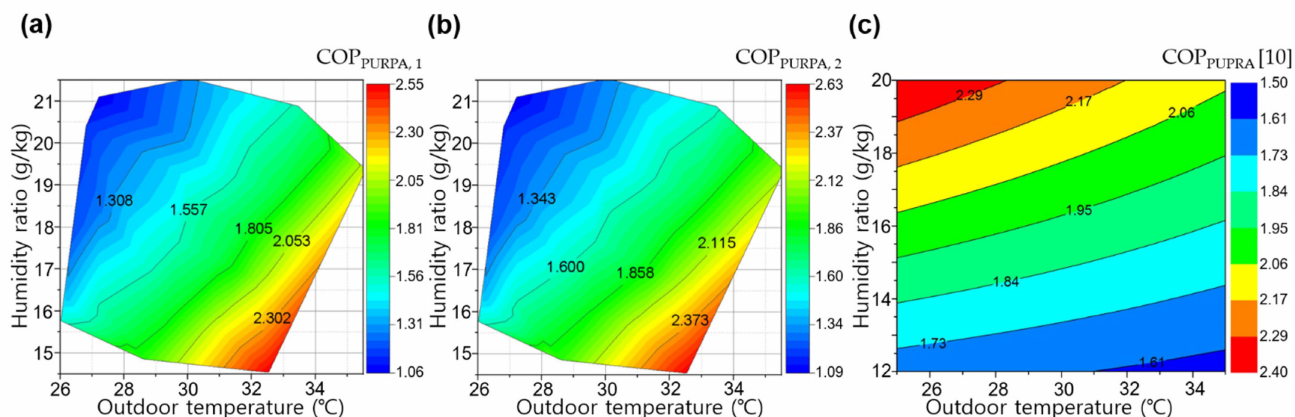
Figure 12. COP with thermoelectric value (COP PURPA ) from the Public Utility Regulatory Policies Act (PURPA) for ( a ) Unit 1 and ( b ) Unit 2. ( c ) Field test data [10] of the COP for the existing